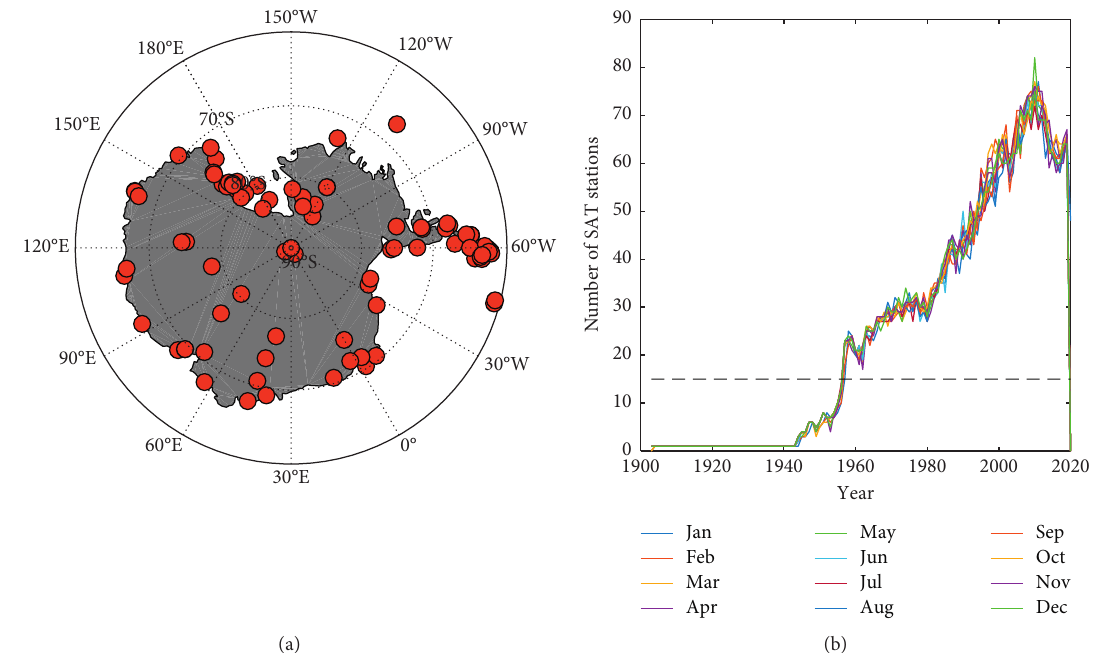
Figure 1: The spatiotemporal distribution of the extracted station-based SAT data of the